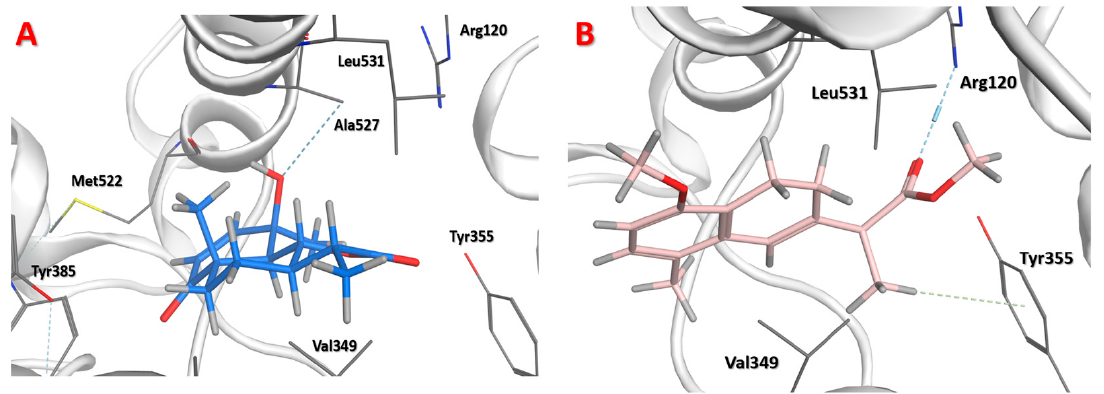
Figure 3. ( A ) Best docking pose of vulgarin shows the interaction with Ala527; ( B ) docking pose of derivative 2 . derivative 2 .